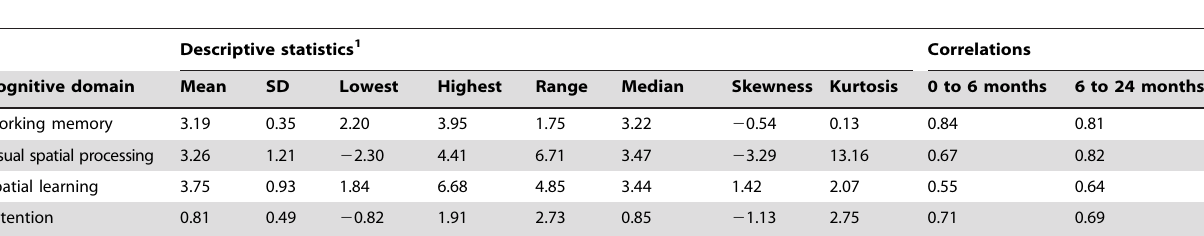
Table 3. Descriptive statistics and test-retest reliabilities of the cognitive